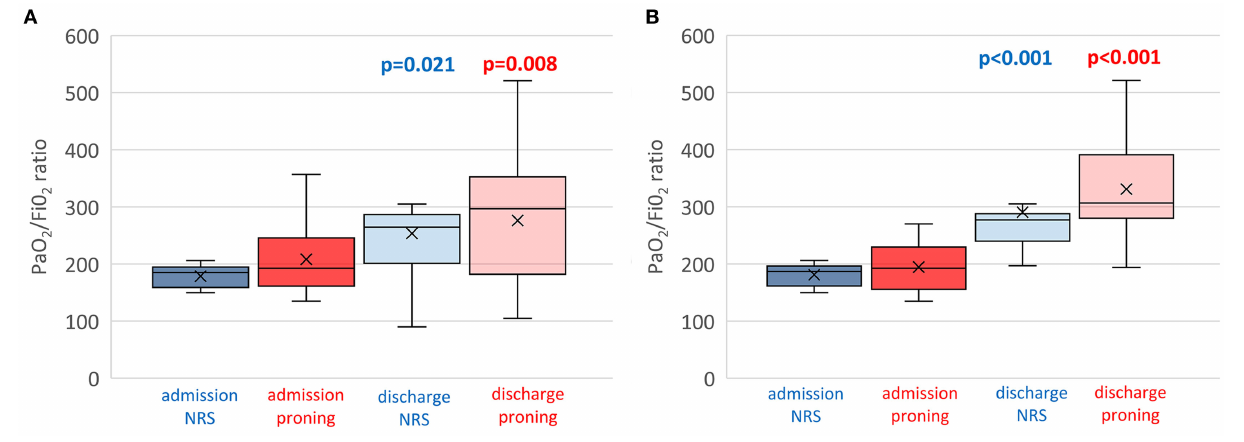
FIGURE 4 | Individual (box plots) and time course of PaO 2 /FiO 2 of both proning and control group on non-invasive respiratory support. (A) Total patients enrolled including dropouts and failures. (B) Only successful patients. Assessments at RICU admission and at RICU discharge. ANOVA, p = 0.001. The x refers to the average value and the continuous line refers to the median